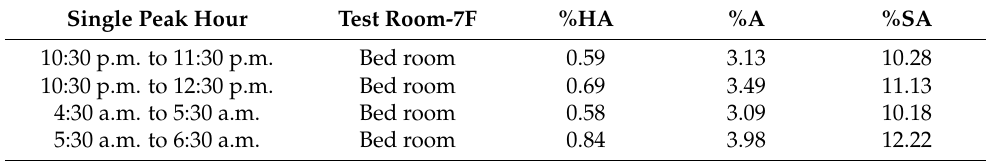
Table 9. Vibration annoyance rate of the seventh-floor test room during peak hours of train operation. Single Peak Hour Test